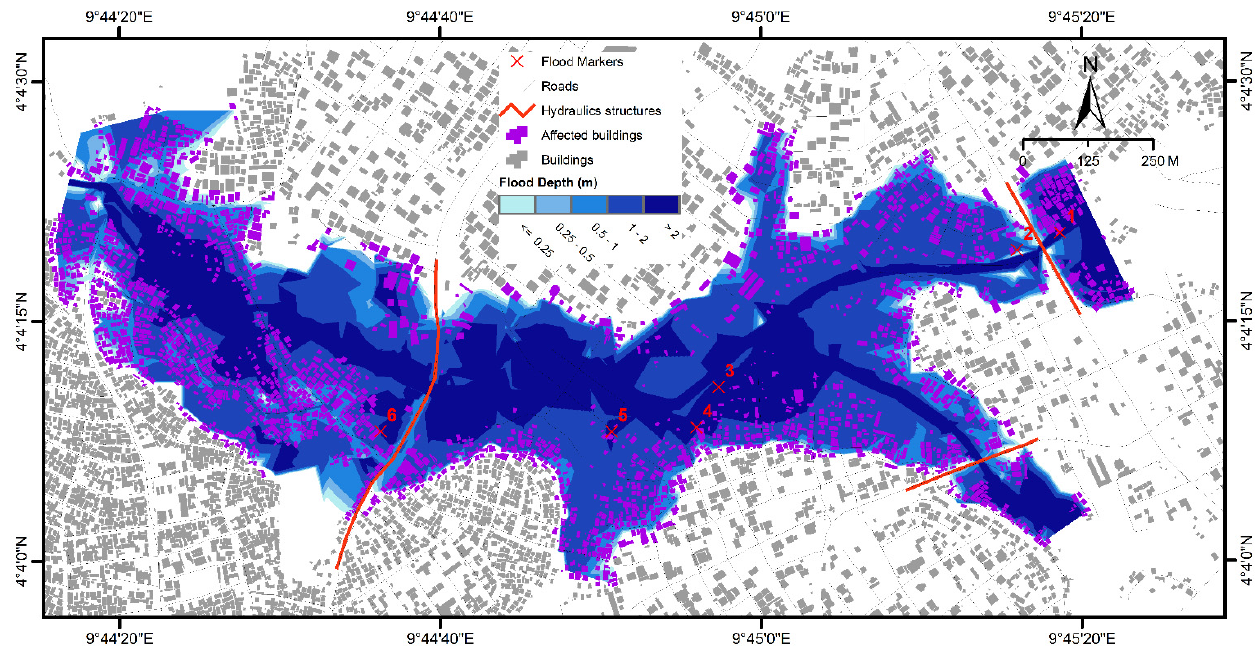
Figure 6. Flood depth (m) within the “Makèpè Missokè” floodplain for the August 2020 (model output).